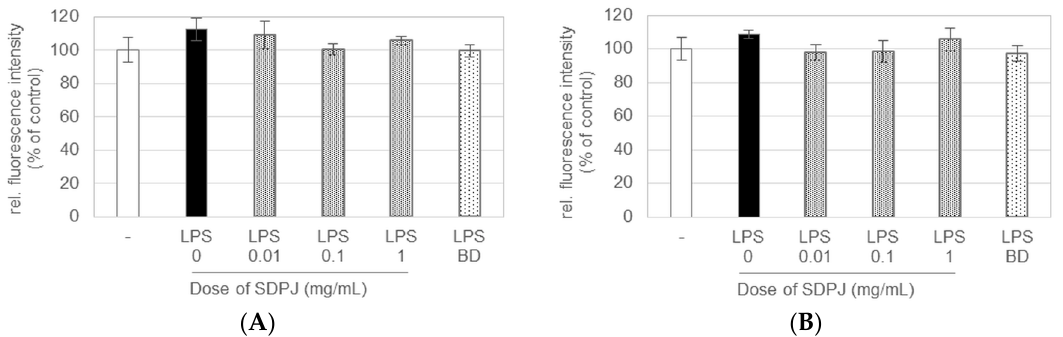
Figure 1. Effect of spray-dried potato juice (SDPJ) and budesonide (BD) on Caco-2 cells ( A ) and RAW264.7 macrophage ( B ) viability determined in a Caco-2/RAW264.7 co-culture system nonstimulated ( − ) or stimulated with lipopolysaccharides (LPS). Values represent the means ± SD ( n = 3).